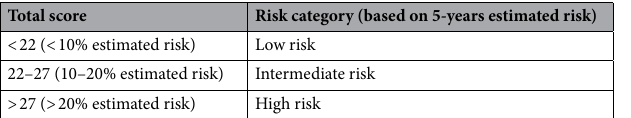
Table 6. Risk categories based on total